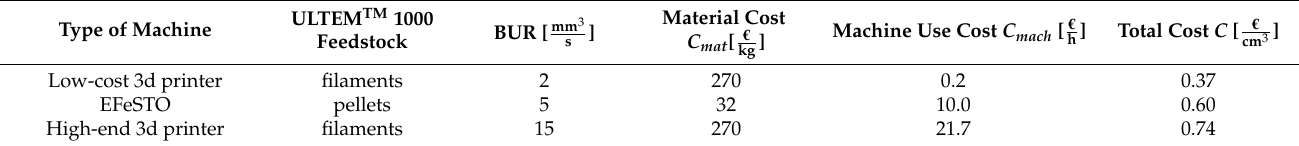
Table 12. Cost scenarios, excluding the labour and overhead